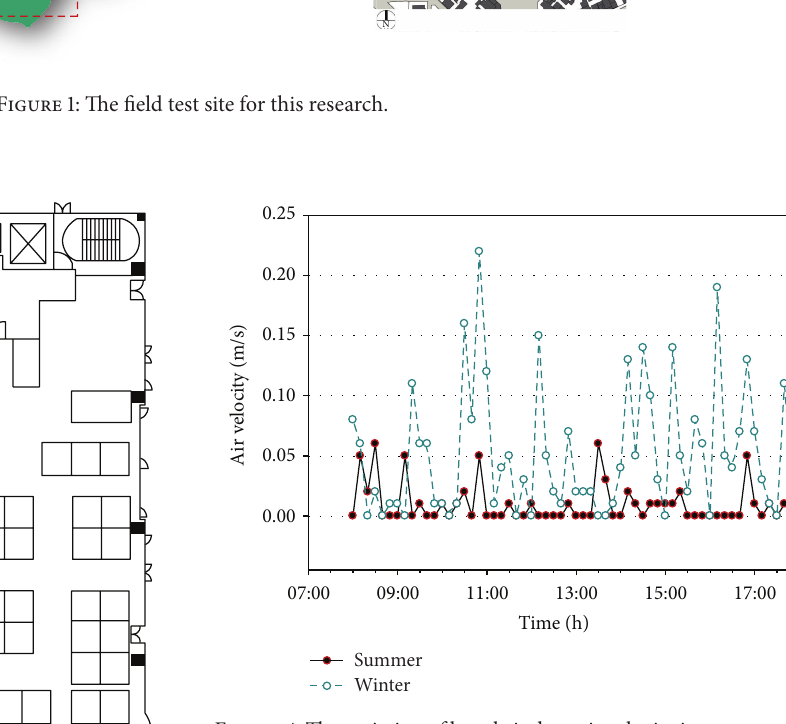
Figure 4: The variation of hourly indoor air velocity in summer and winter,